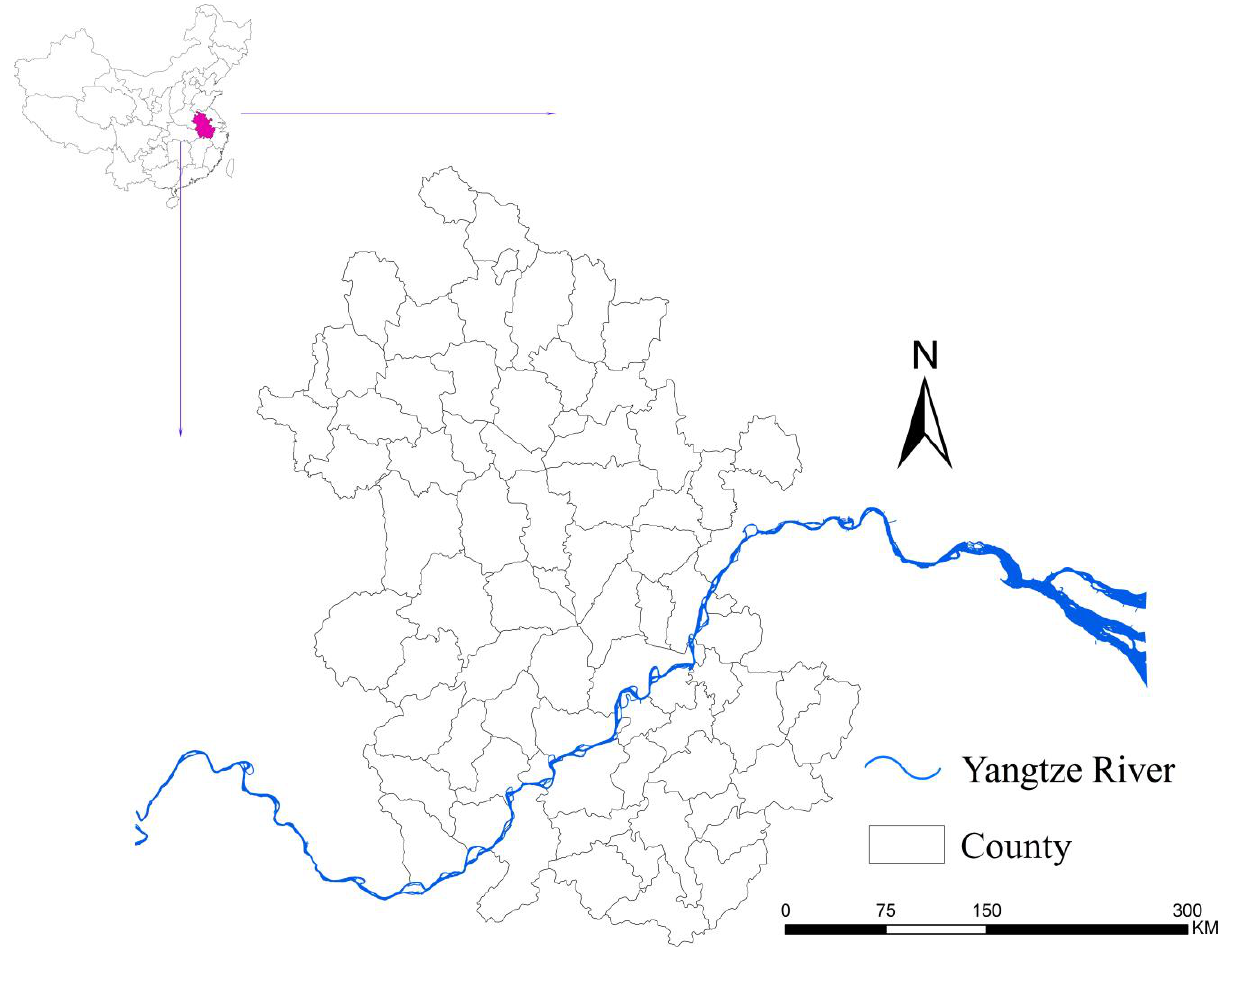
Figure 1. Location of Anhui Province, China. The maps were created using the ArcGIS 10.0 software (ESRI Inc., Redlands, CA,